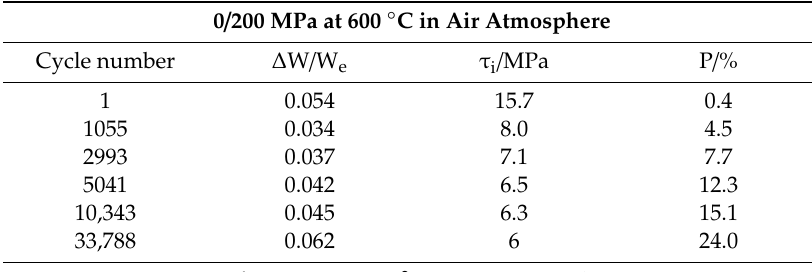
Table 4. Cycle-dependent damage evolution of 2.5D woven self-healing Hi-Nicalon TM SiC / [Si-B-C] composite at 600 ◦ C in an air